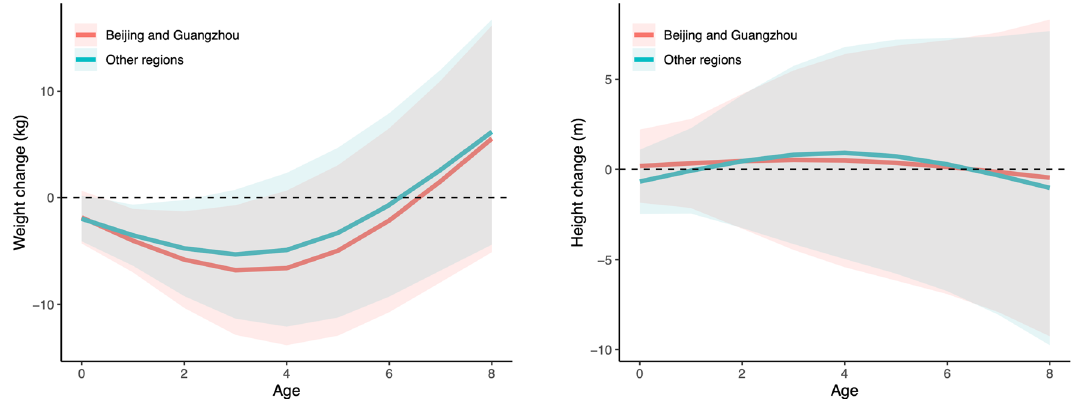
Figure 1. Associations between SARS and body weight (left) and height (right) by age and region. The lines present the estimated associations and the ribbons present the corresponding 95% confidence